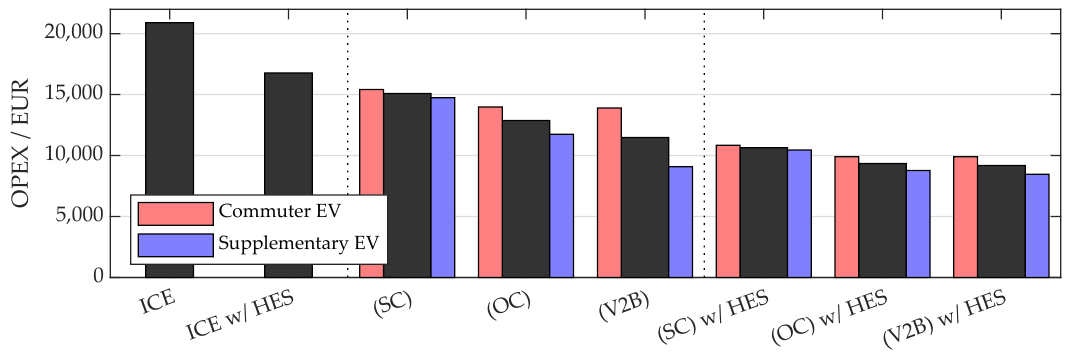
Figure 7. Operating expenses (OPEX) for ten years. Compound annual growth rate (CAGR) of energy costs are considered, so that costs for ten years are more than ten times the one-year costs. The dark-grey column represents the average